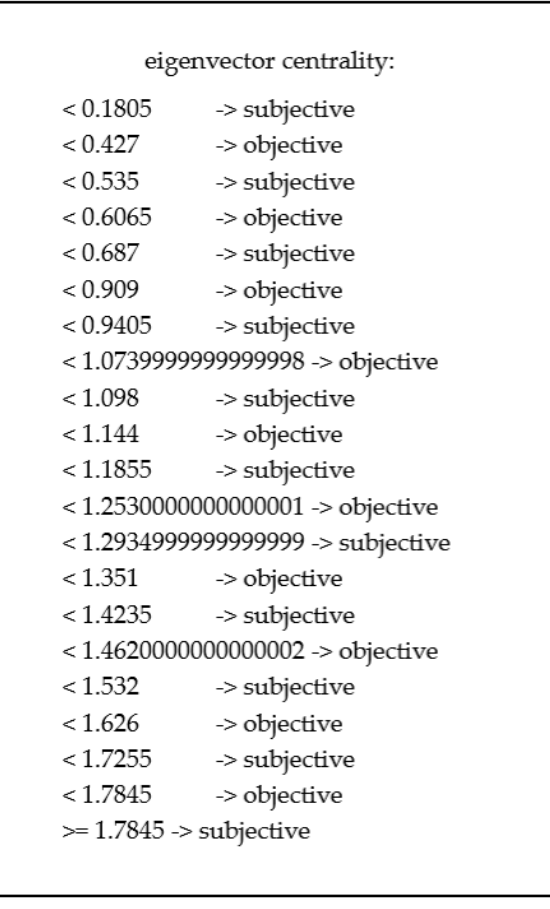
Figure 2. Rule learned by the OneR technique using all the features.